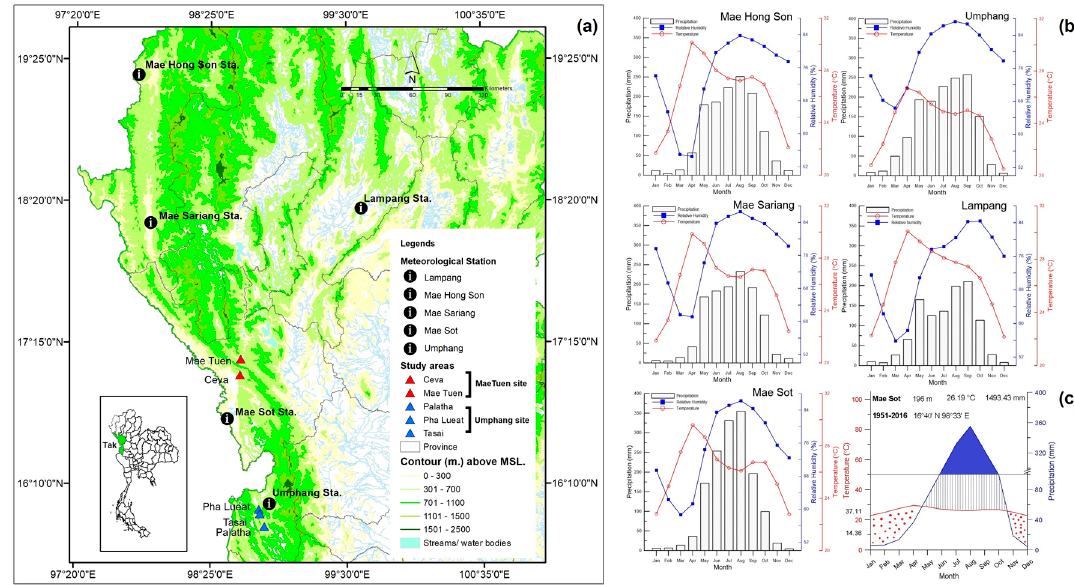
Figure 1. ( a ) Map of the study areas, Mae Tuen (MT) (red triangles) and Umphang (UP) (blue triangles) and the meteorological stations (black circles). ( b ) Mean climate conditions; mean monthly rainfall (gray vertical bars), temperature (red line with circles), and relative humidity (blue line with filled squares) in the period of 1951–2016 from Mae Hong Son (19 ◦ 18 (cid:48) N, 97 ◦ 50 (cid:48) E), 1951–2016 from Mae Sariang (18 ◦ 10 (cid:48) N, 97 ◦ 56 (cid:48) E), 1951–2016 from Mae Sot (16 ◦ 40 (cid:48) N, 98 ◦ 33 (cid:48) E), 1977–2016 from Umphang (16 ◦ 01 (cid:48) N, 98 ◦ 51 (cid:48) E), and 1951–2016 from Lampang (18 ◦ 17 (cid:48) N, 99 ◦ 11 (cid:48) E) Meteorological Station. ( c ) Walter and Lieth climate diagram; mean monthly rainfall (blue line) and temperature (red line) from Mae Sot Meteorological Station (the period of 1951–2016), dry period (red dot area), humid period (blue line area), and wet period (blue area).